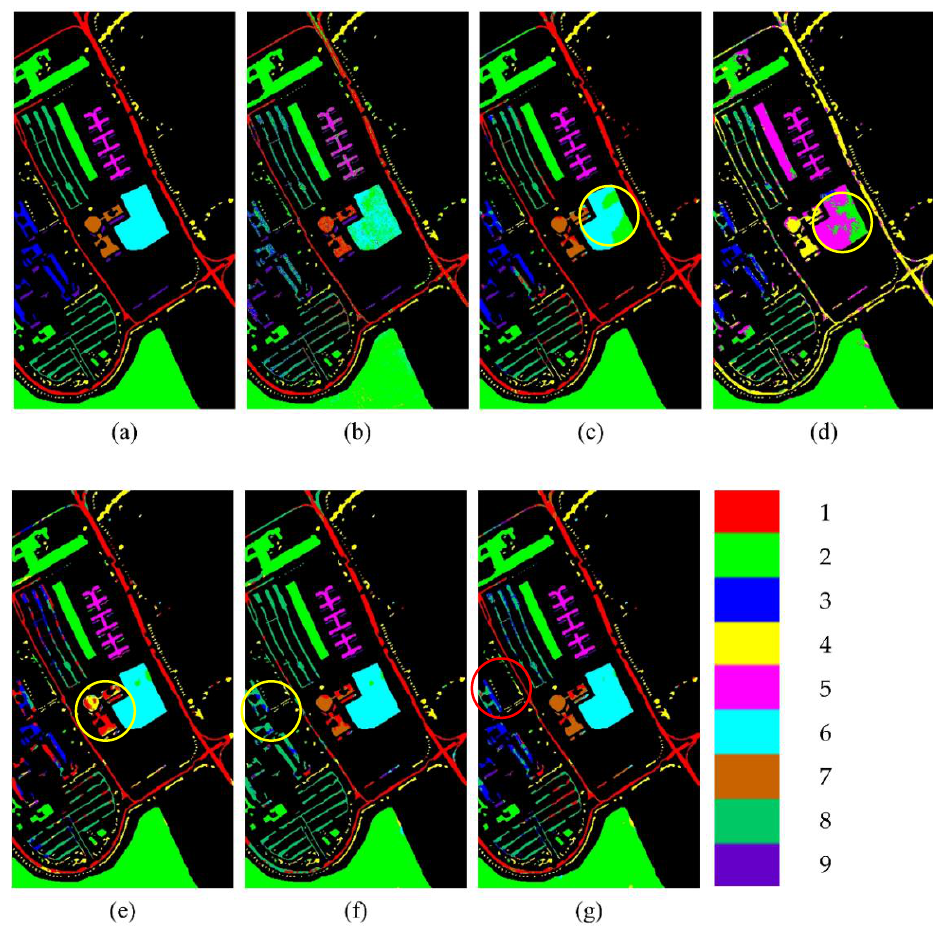
Figure 6. Ground truth and classification results of the PU dataset: ( a ) ground truth; ( b ) SVM; ( c ) 2D CNN; ( d ) 3D CNN; ( e ) 3D–2D–1D CNN; ( f ) 3D–2D–CBAM–1D CNN; ( g ) MDAN (3D–2D–CBSM–1D